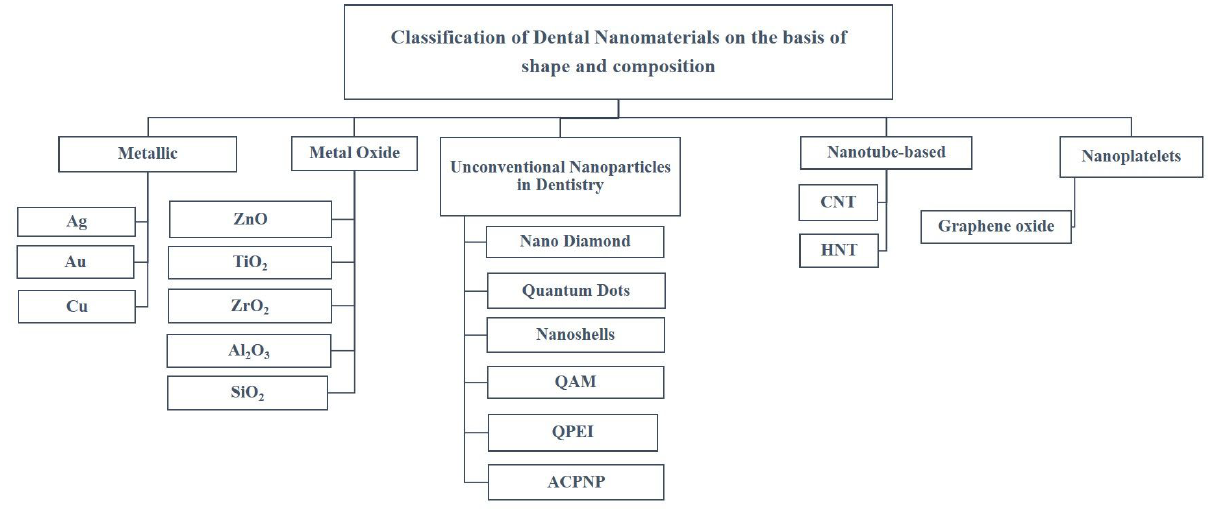
Figure 2: Classification of Dental Nanomaterials on the bases of shape and